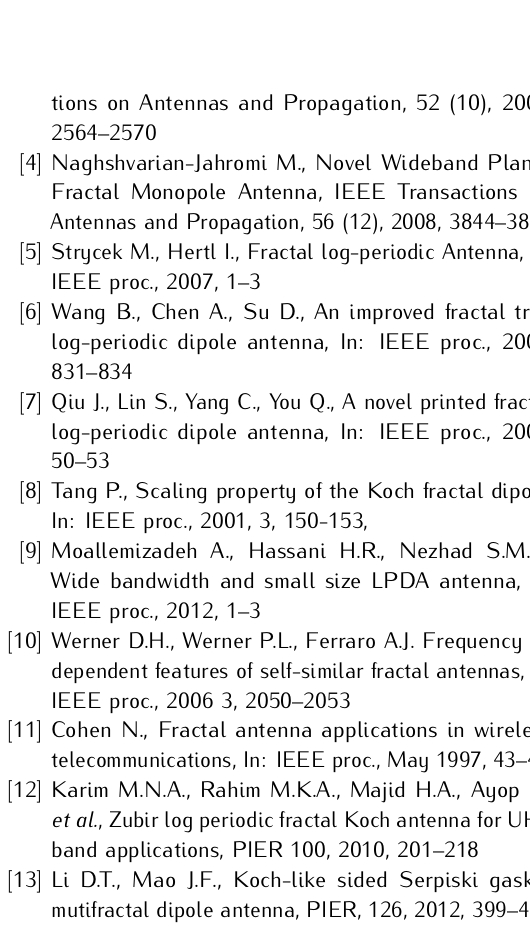
Figure 18. S-parameter (dB) plots of log periodic antenna (dotted line) and log periodic Koch fractal with 60° flare angle Vs. Frequency (GHz).